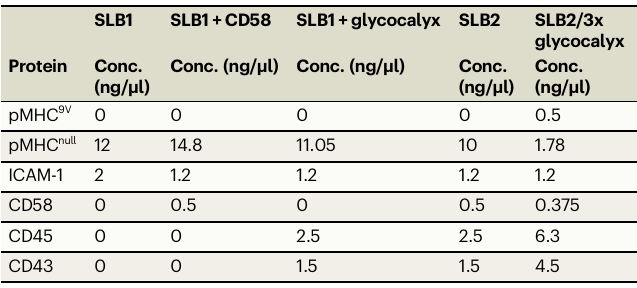
Table 1 | Protein concentrations used for different SLB compositions